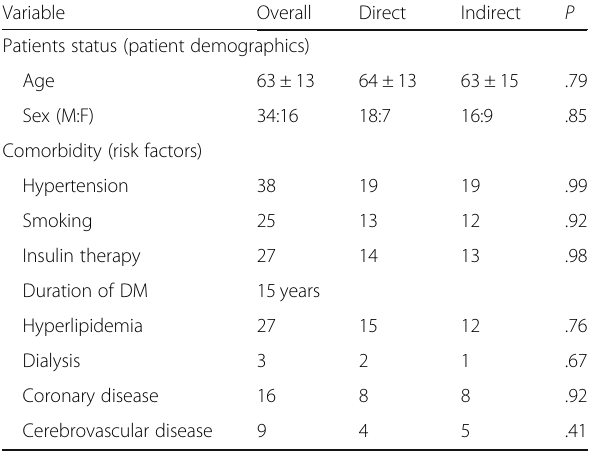
Table 1 Patient characteristics (demographics and comorbidity) Variable Overall